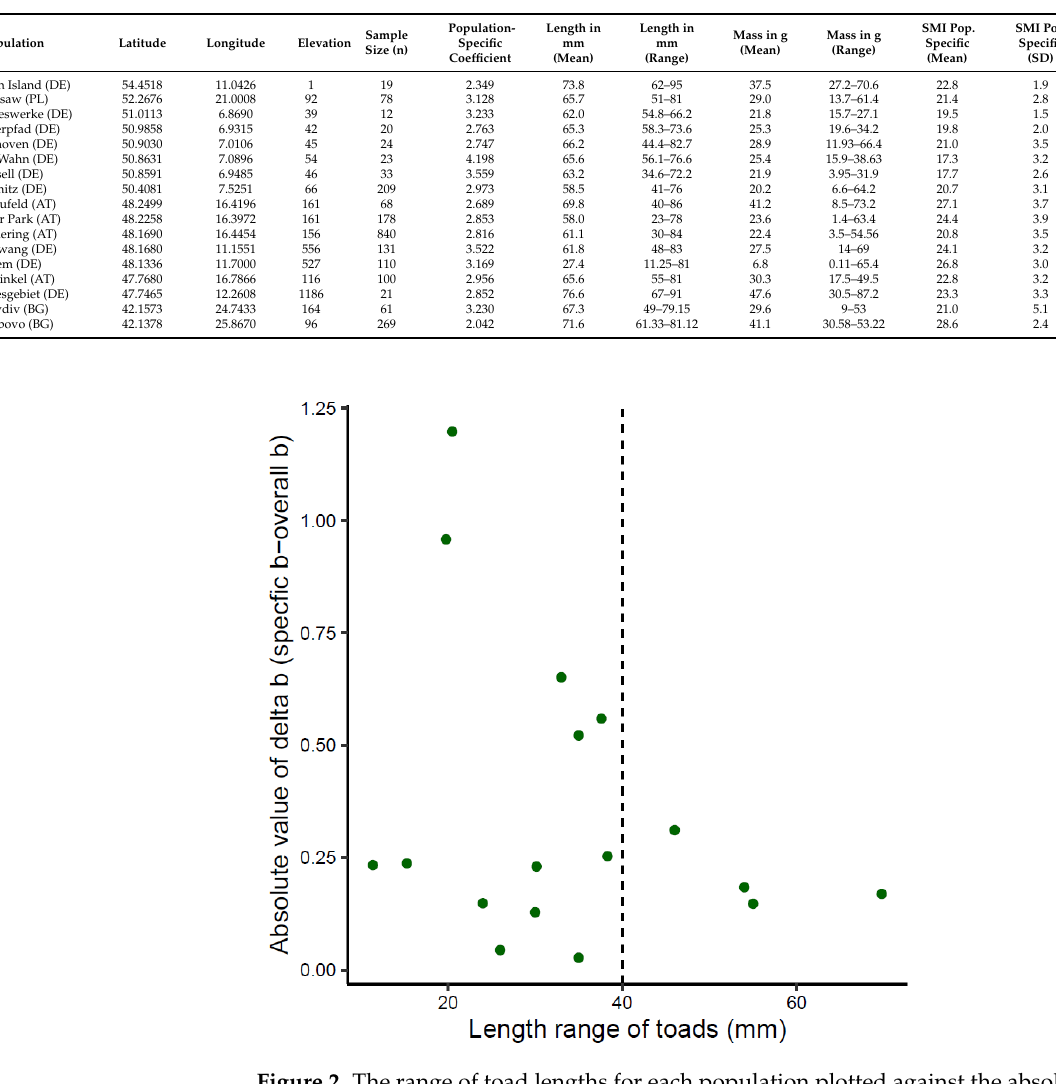
Figure 2. The range of toad lengths for each population plotted against the absolute differences between the green toad coefficient (overall b) and population-specific coefficient (specific b). Variations around the mean decreased with a larger length range; above 40 mm (dashed line) variation remained under 0.5.